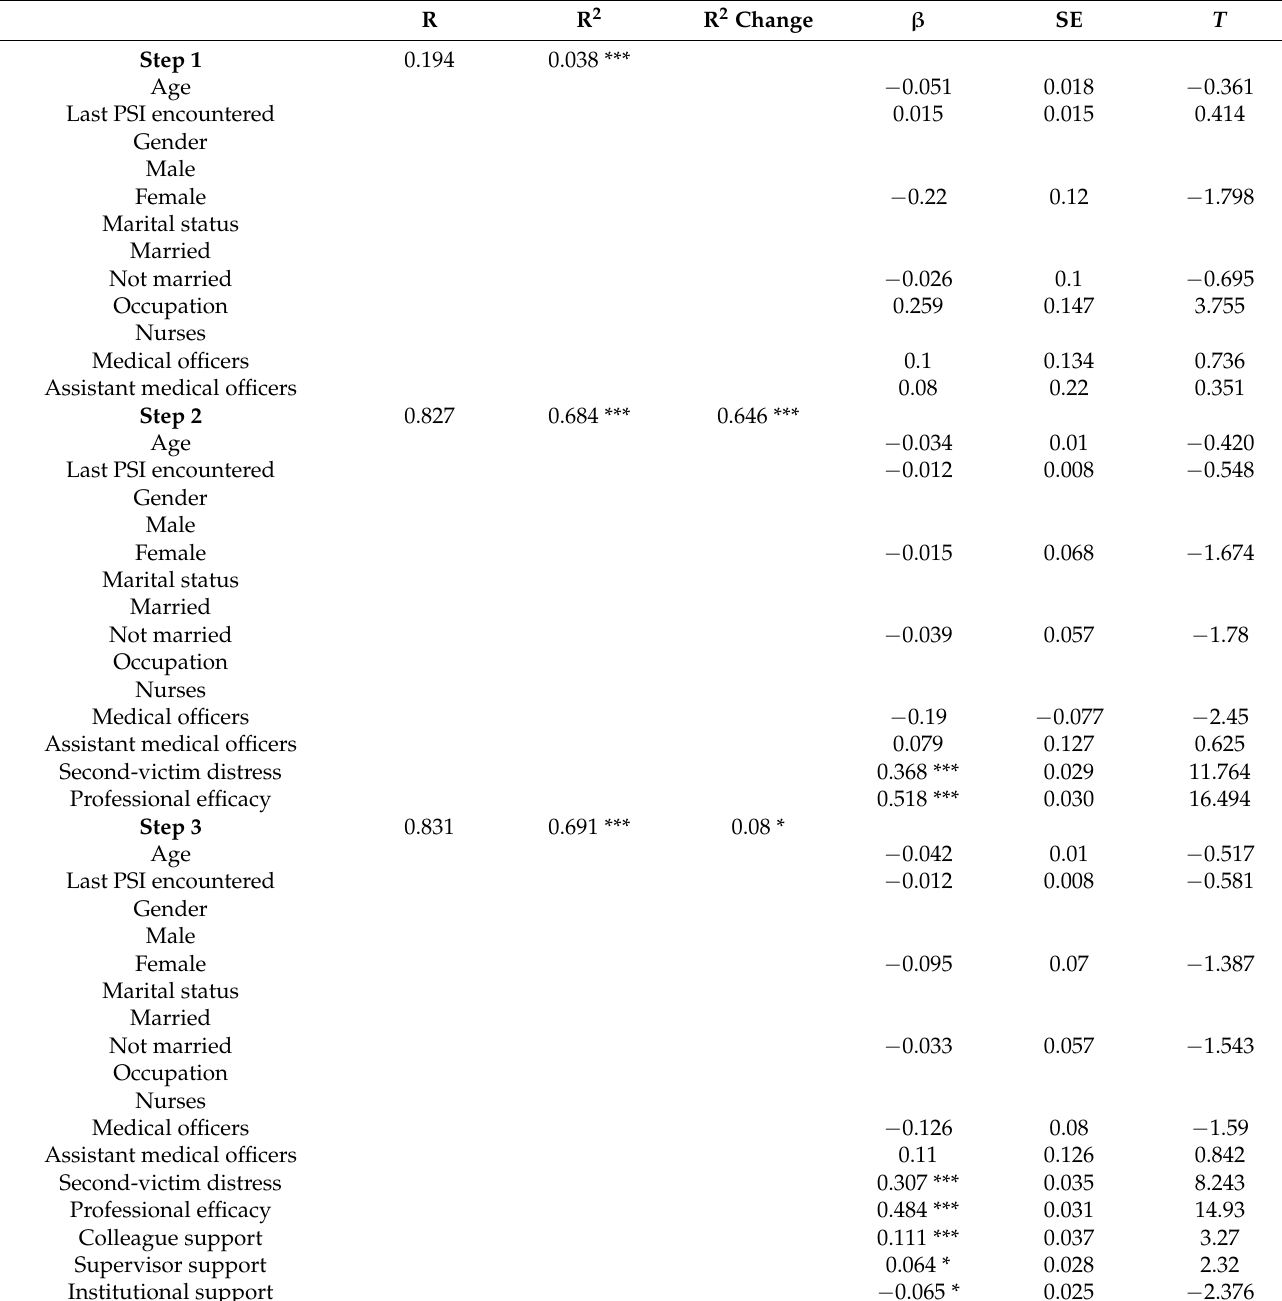
Table 2. Hierarchical regression model of negative work-related